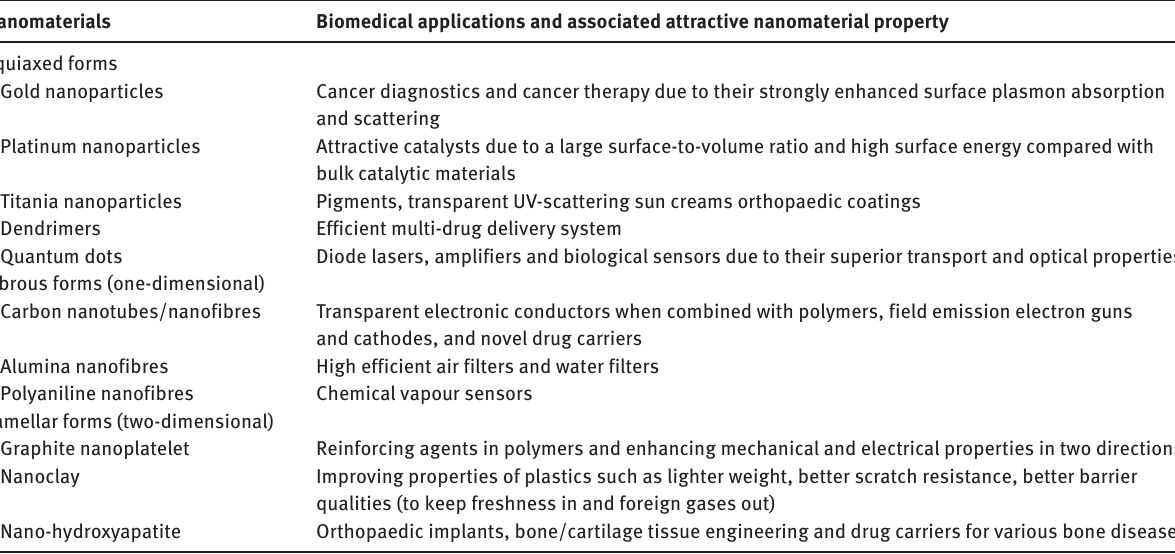
Table 1 Selected nanomaterials and its associated biomedical applications [2].